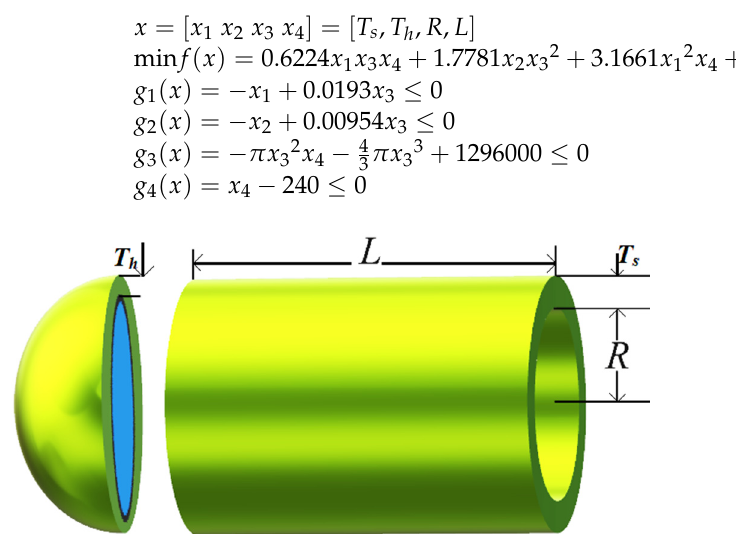
Figure 7. Cylindrical vessel design. Table 13. Optimal design of pressure vessel.